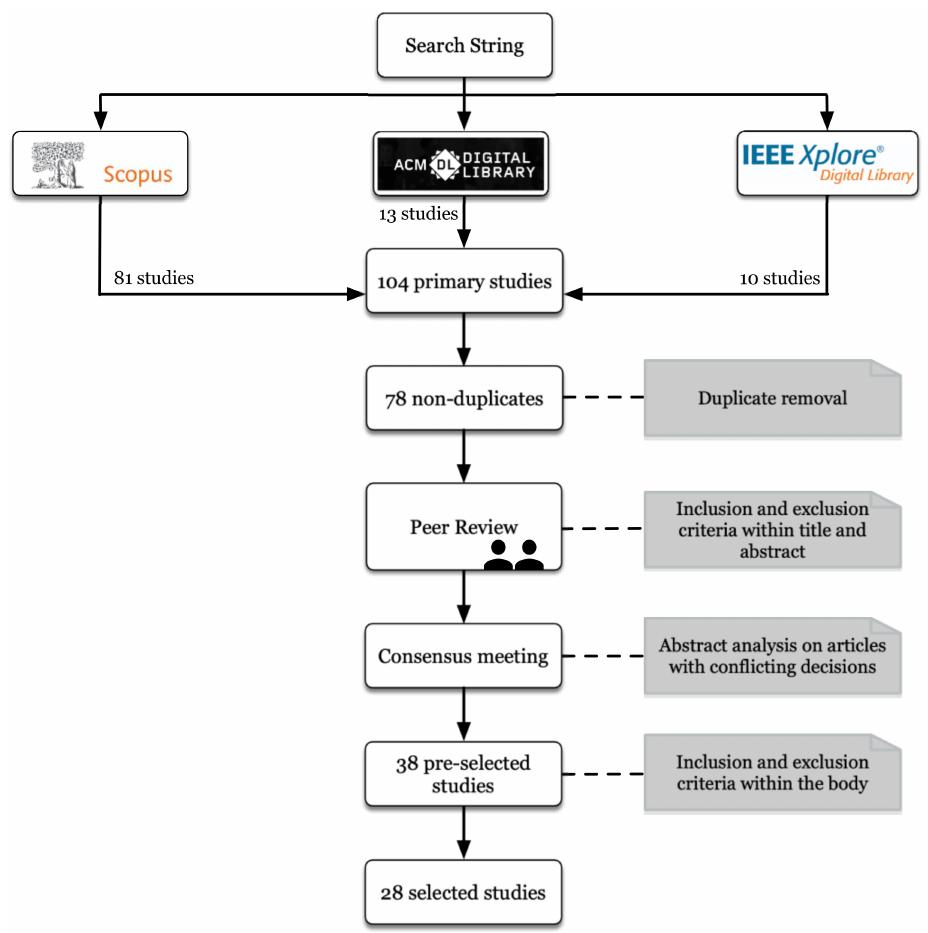
Figure 1. Steps followed during the systematic mapping